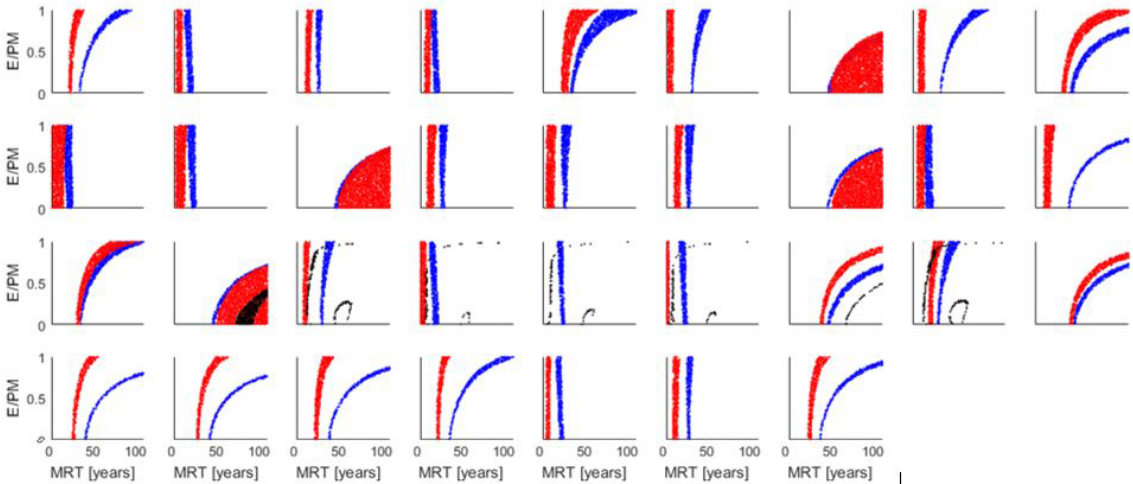
Figure A7. Behavioural age information (MRT and E / PM) inferred from SF 6 (red), tritium (black) and Halon-1301 (blue) for sites 268 to